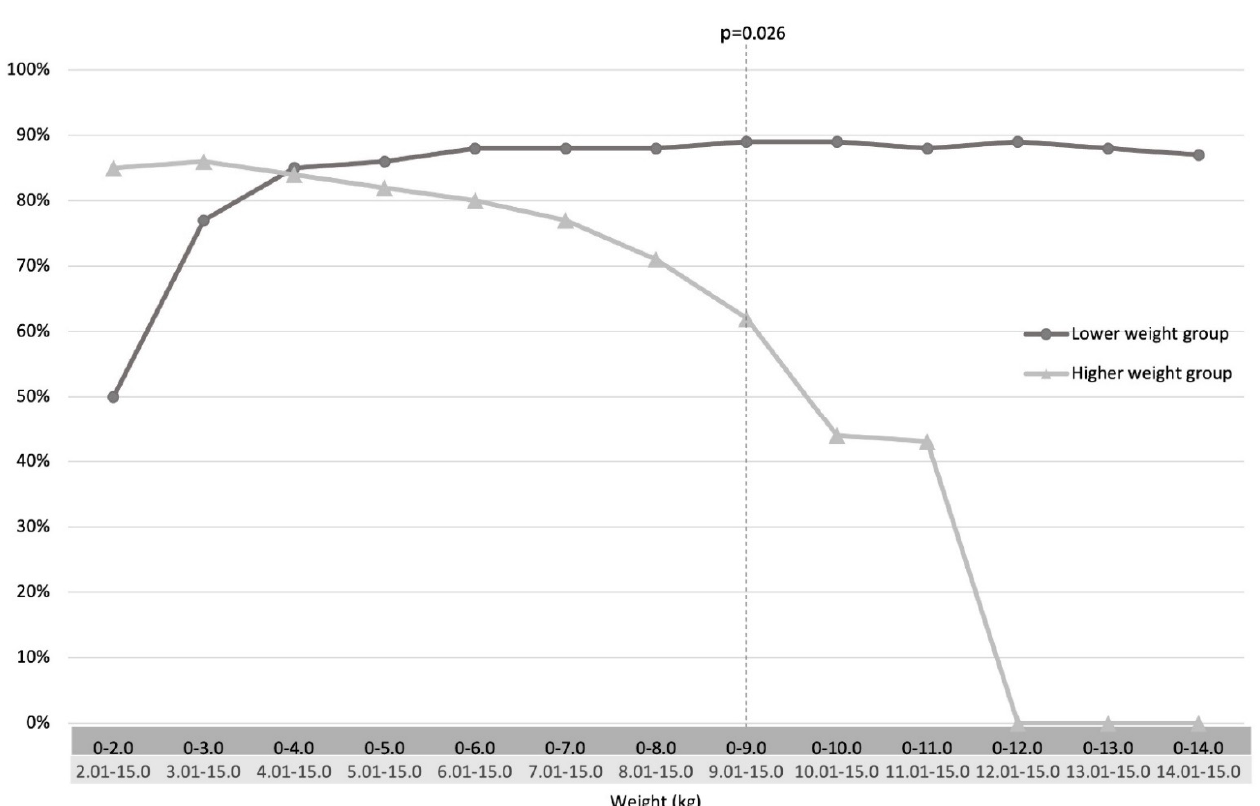
Figure 2. Flowchart of outcome of first-time rectal suction biopsy (RSB) in patients examined for Hirschsprung’s disease (HD).